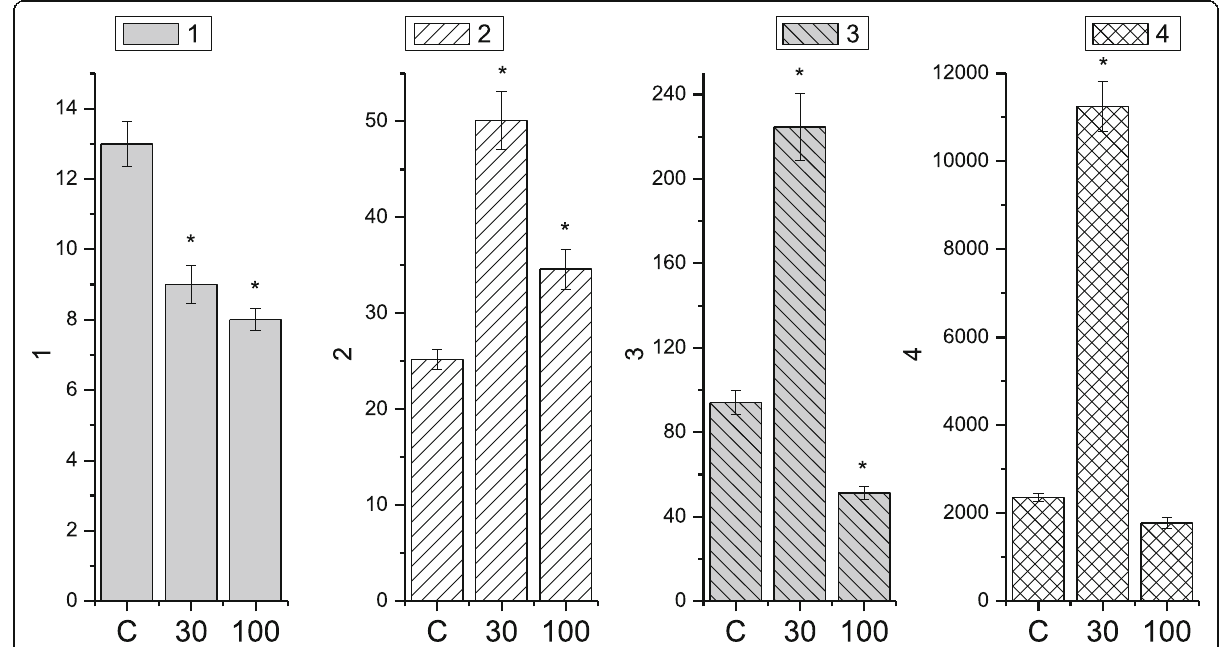
Fig. 6 Histograms of the kinetic analysis parameters for spontaneous contractive activity of circular smooth muscles of the caecum ( C , control; 30 and 100, term (days) of burdening the rats with the suspension of nanosize titanium dioxide material): (1) frequency of preparation contractions for 10 min; (2) averaged value of the duration of contraction – relaxation cycle (sec); (3) MU index of contractions; and (4) AU index of contractions. * p < 0.05, reliability of changes compared to the